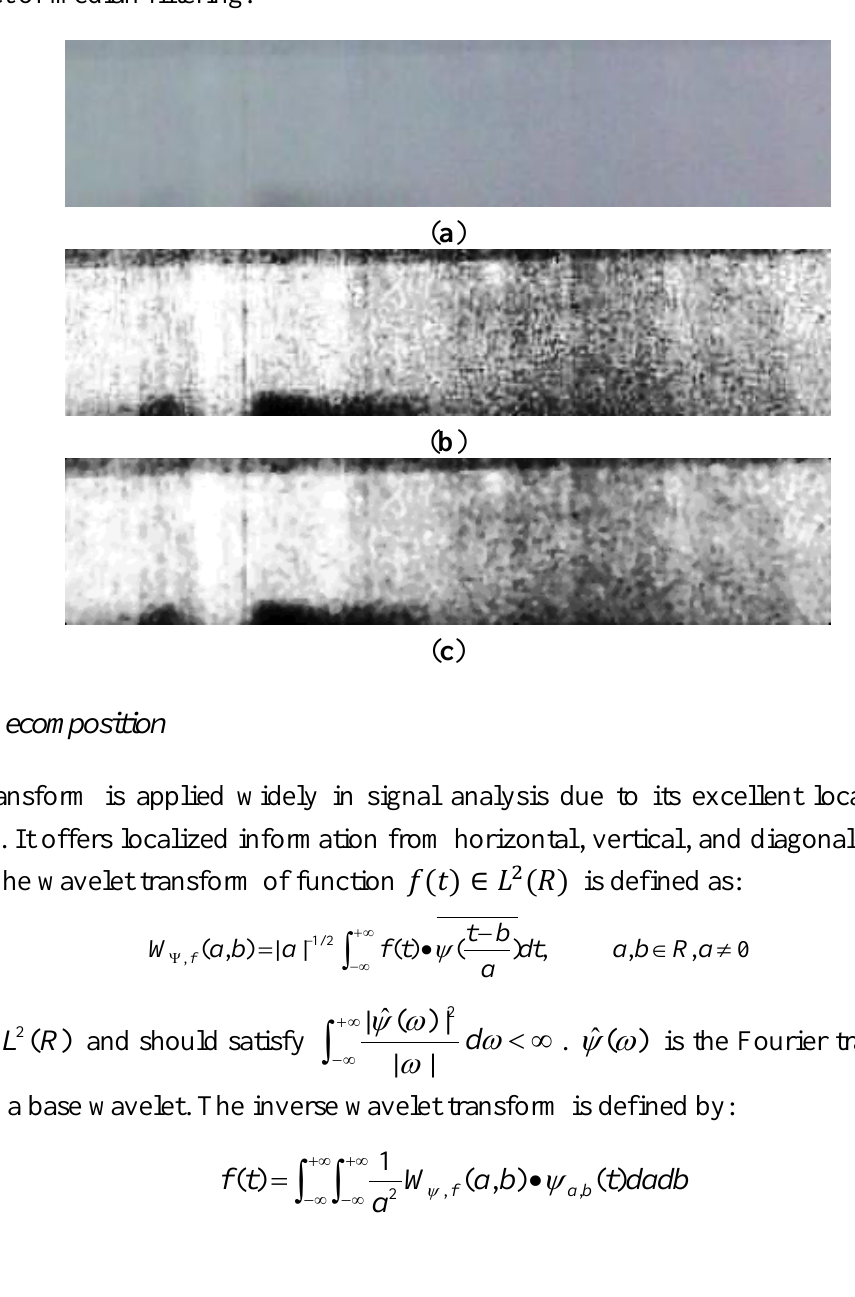
Figure 7. ( a ) Raw image captured by visual sensor; ( b ) Effect of image equalization; and ( c ) Effect of median